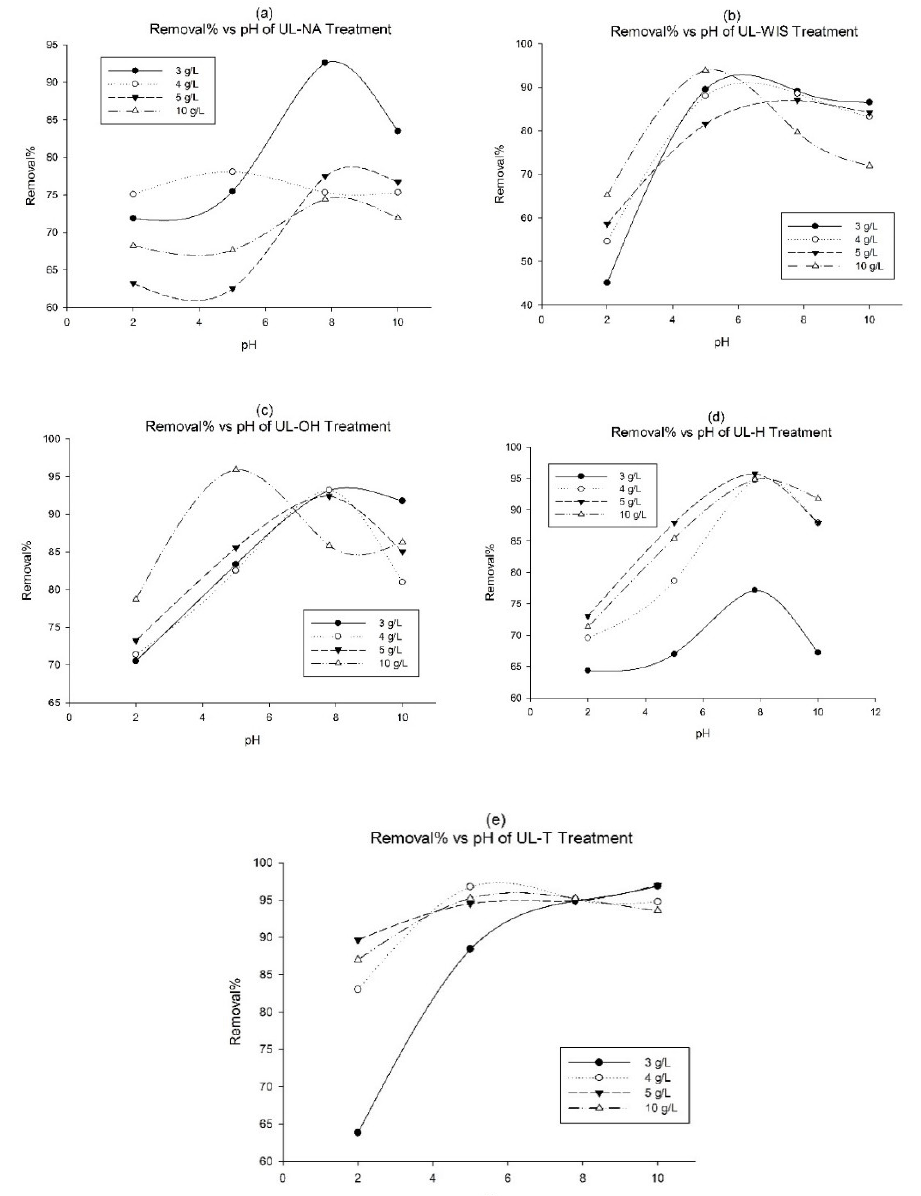
Figure 9. The effect of pH on adsorption of MB from aqueous solution onto dry algal biomass, UL-NA ( a ), UL-WIS ( b ), UL-OH ( c ), UL-H ( d ) and UL-T ( e ) at different adsorbent